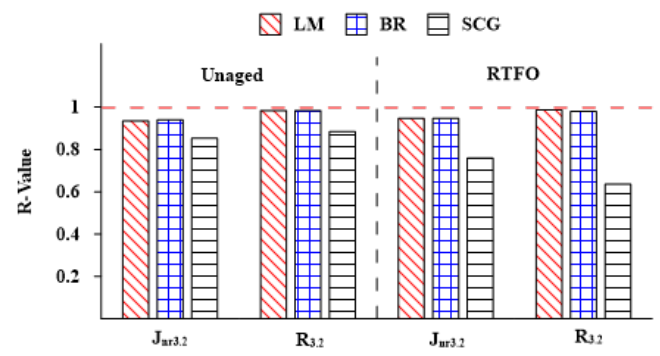
Figure 8. R-values for different training algorithms.